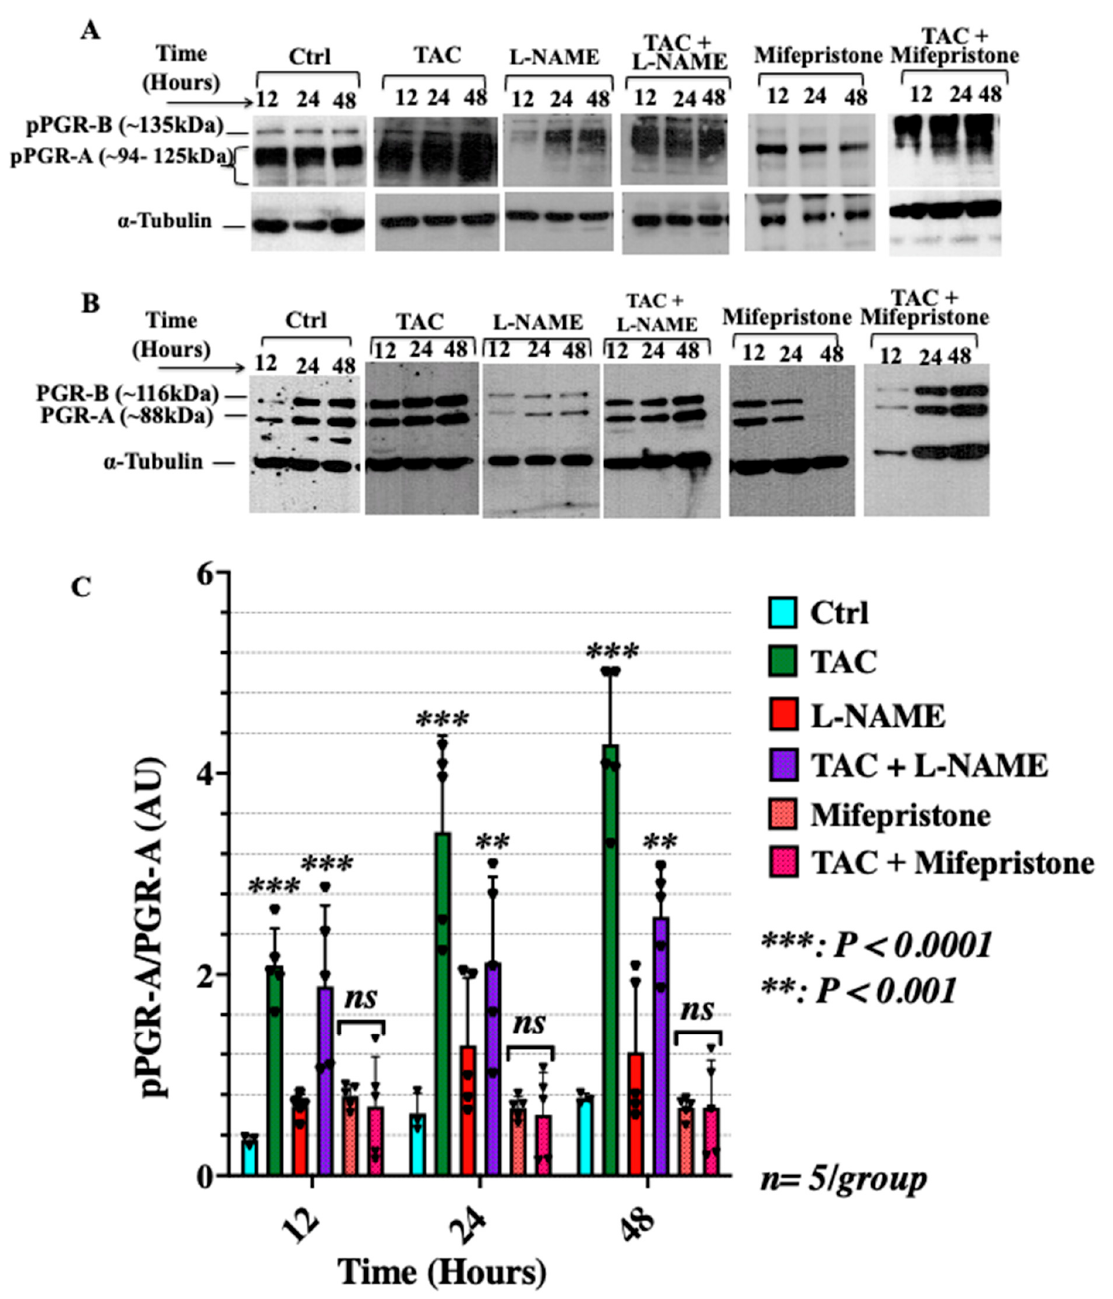
Figure 2. Tacrolimus abrogates the suppressive effects of L-NAME and mifepristone, inducing the expression and activation of PGR in HTR-8/SVneo cells. ( A , B ) Representative Western blots of pPGR-A and p-BGR-B ( A ) and PGR-A and PGR-B ( B ) in HTR-8/SVneo cells treated, respectively, with low-dose tacrolimus (10 ng/mL), L-NAME or mifepristone, and in combination formulations for 12, 24 and 48 h. ( C ) Histogram depicting the relative expression ratio of pPGR-A/PGR-A shown in ( A , B